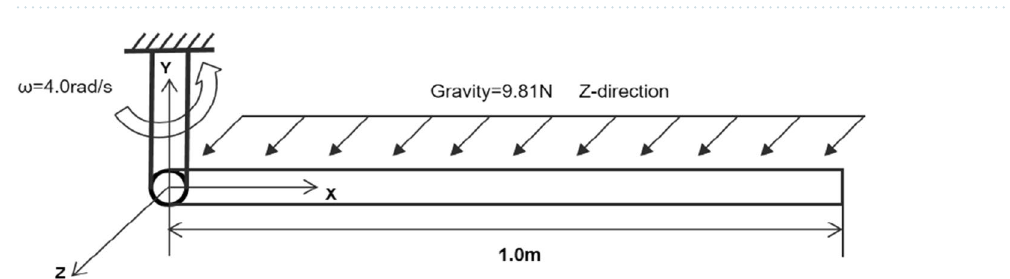
Figure 9. Flexible pendulum model in three dimensional motion.